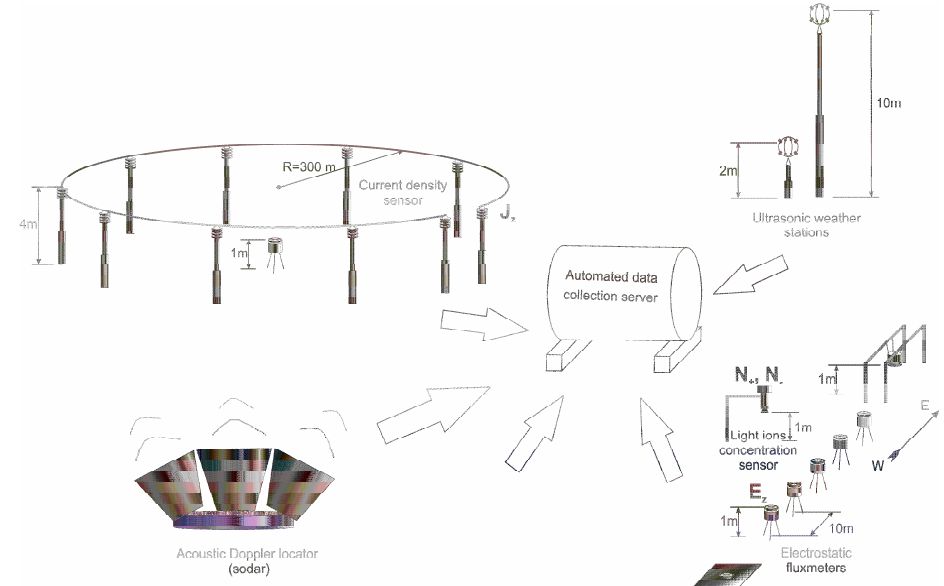
Fig. 1. Experimental set-up scheme.